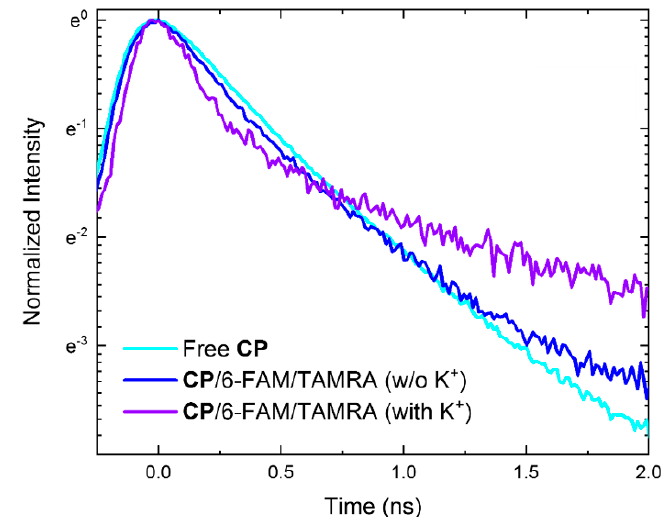
Figure 3. Fluorescence decay dynamics of CPs without the complexation with the two-dye-labeled (i.e., 6-FAM and TAMRA) aptamer (Free CP), in the absence ( w / o ) and presence (with) of K + ions after the complexation with the two-dye-labeled aptamer.